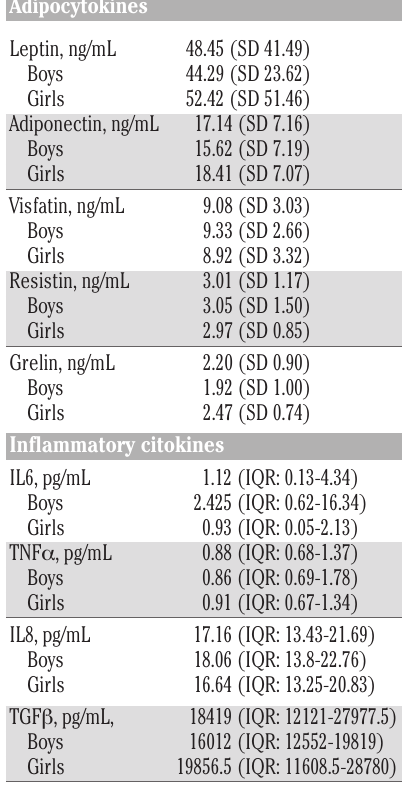
Table 2. Plasmatic adipocytokines and inflammatory cytokines